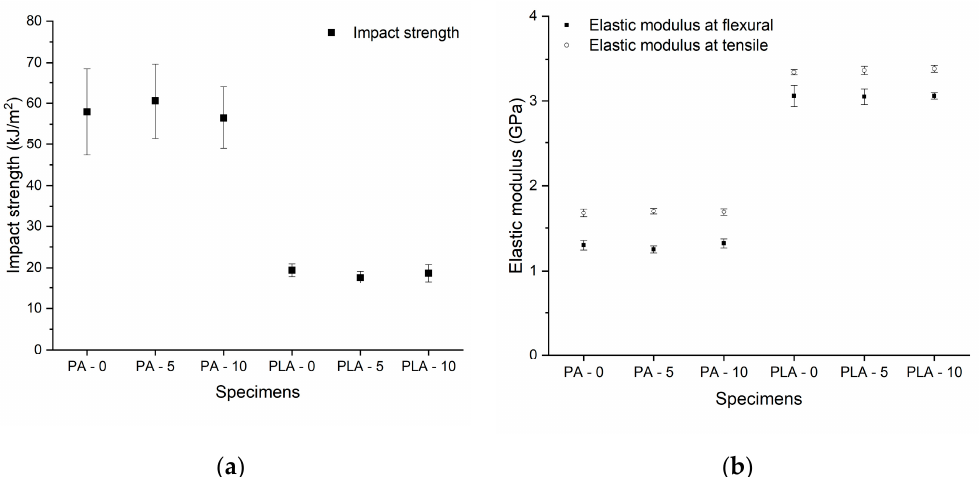
Figure 2. Results of mechanical tests. ( a ): The results of impact strength test (kJ/m 2 ). The black squares indicate the means of the impact strength with the standard error in the case of the Charpy test. ( b ): The results of 3-point bending and tensile strength tests. The black squares indicate the means of elastic modulus with the standard error in the case of flexural test (GPa), while the dots show the means of elastic modulus in the case of tensile test (GPa), with the standard error. The test specimens are marked as: PA/PLA—0: Non-disinfected; PA/PLA—5: disinfected with 5 cycles; PA/PLA—10 disinfected with 10 cycles.